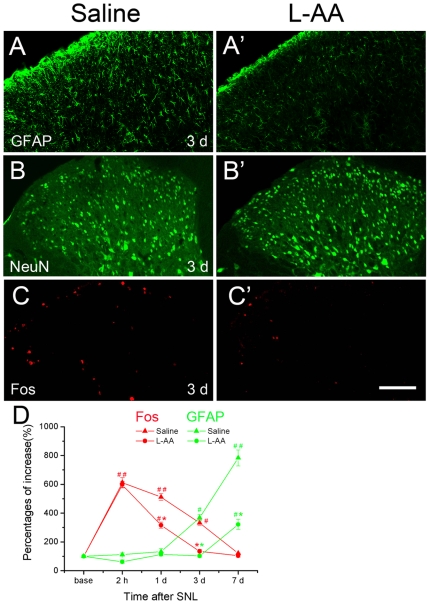
The effects of L-AA on astrocytic activation and Fos expression in the ipsilateral dorsal horn induced by SNL.Compared to the saline control group, L-AA produced a marked reduction of GFAP-positive astrocytes in the dorsal horn (A, A'). L-AA did not influence the numbers of NeuN-expressing neurons indicating the specific role of this astroglial toxin (B, B'). How ever, it did significantly suppress the Fos expression on POD 3 (C, C'). D, The changing course of astrocytic activation and Fos expression after L-AA administration to the SNL rats. The baseline level of Fos and GFAP was set as 100%, respectively. The changing course of Fos (red curves) or GFAP (green curves) was determined with comparison to the relative baseline value. L-AA postponed astrocytic activation from day 3 (saline control) to day 7. Meanwhile, this astroglial toxin shortened the duration of Fos expression from 7 d (saline control) to 3 d post SNL, although it did not change the peak level of Fos expression. #, P<0.05 and # #, P<0.01, as compared to the baseline value; *, P<0.05 and **, P<0.01, as compared to the saline control in the same time point. Scale bar = 200 µm.